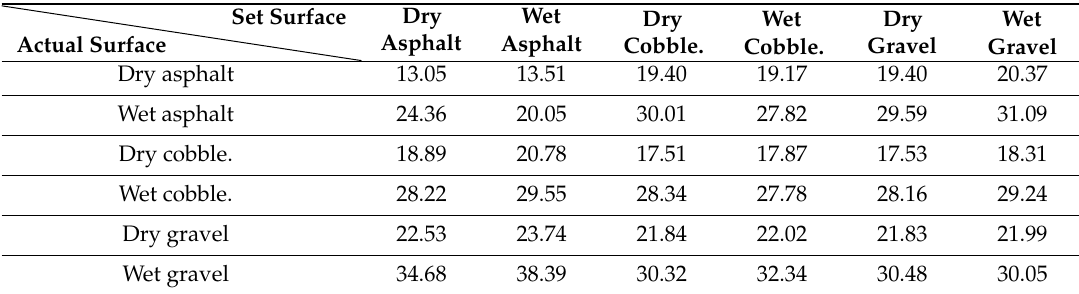
Table 6. Stopping distance with wrong